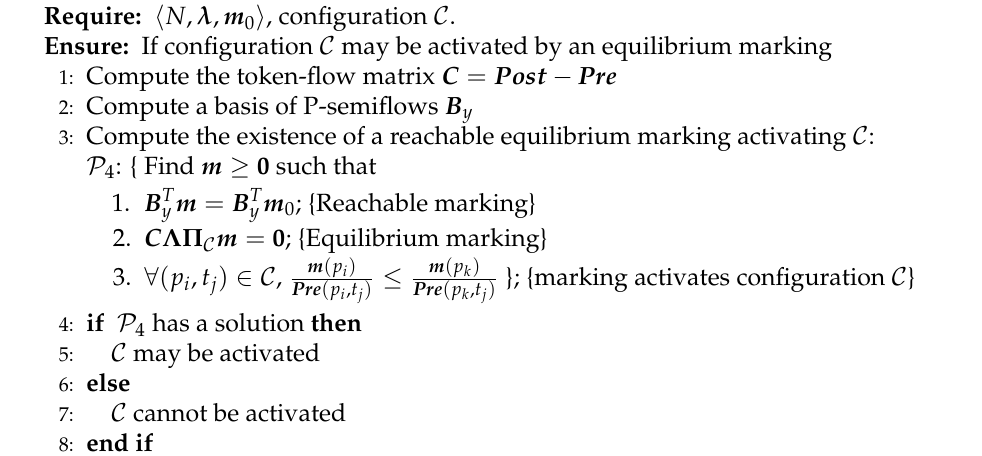
Algorithm 4 Computing if a given configuration can be activated by an equilibrium marking. Require: (cid:104) N , λ , m 0 (cid:105) , configuration C